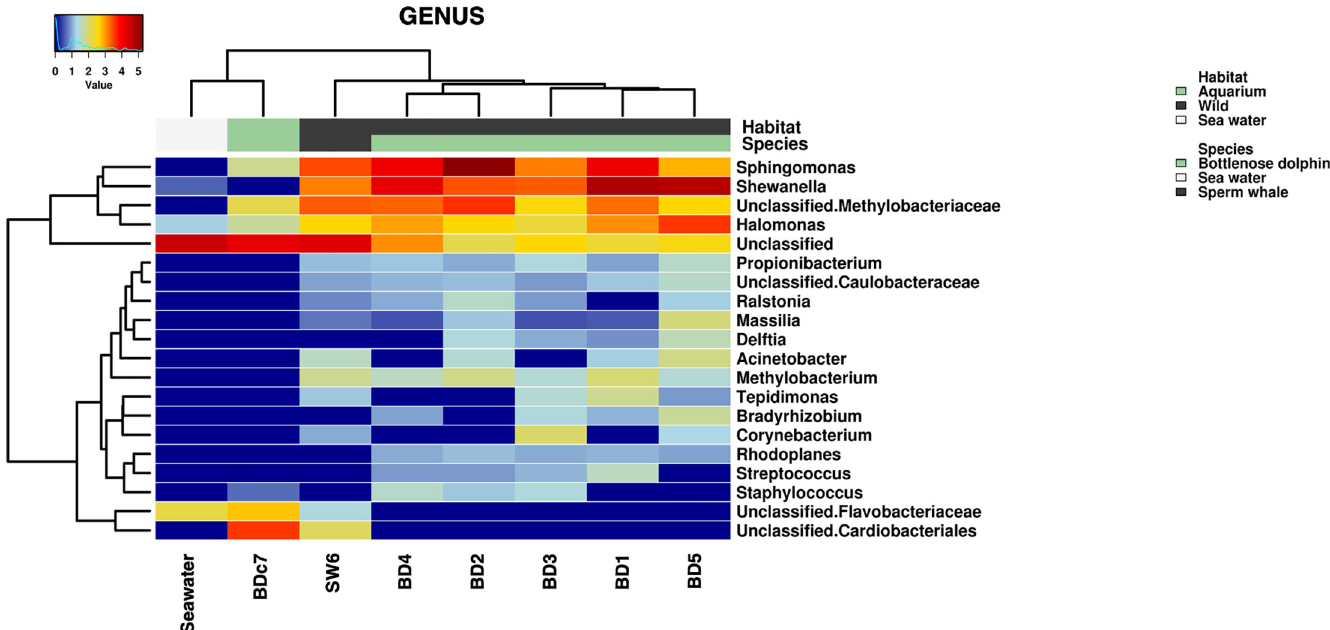
Fig 7. Hierarchical clustering of blow and the pooled water sample based on the most aboundant Genera by looking at the top 20 taxa in each sample. Taxa abundance are presented in color code ranging from red (highly abundant) to blue (rare or absent).